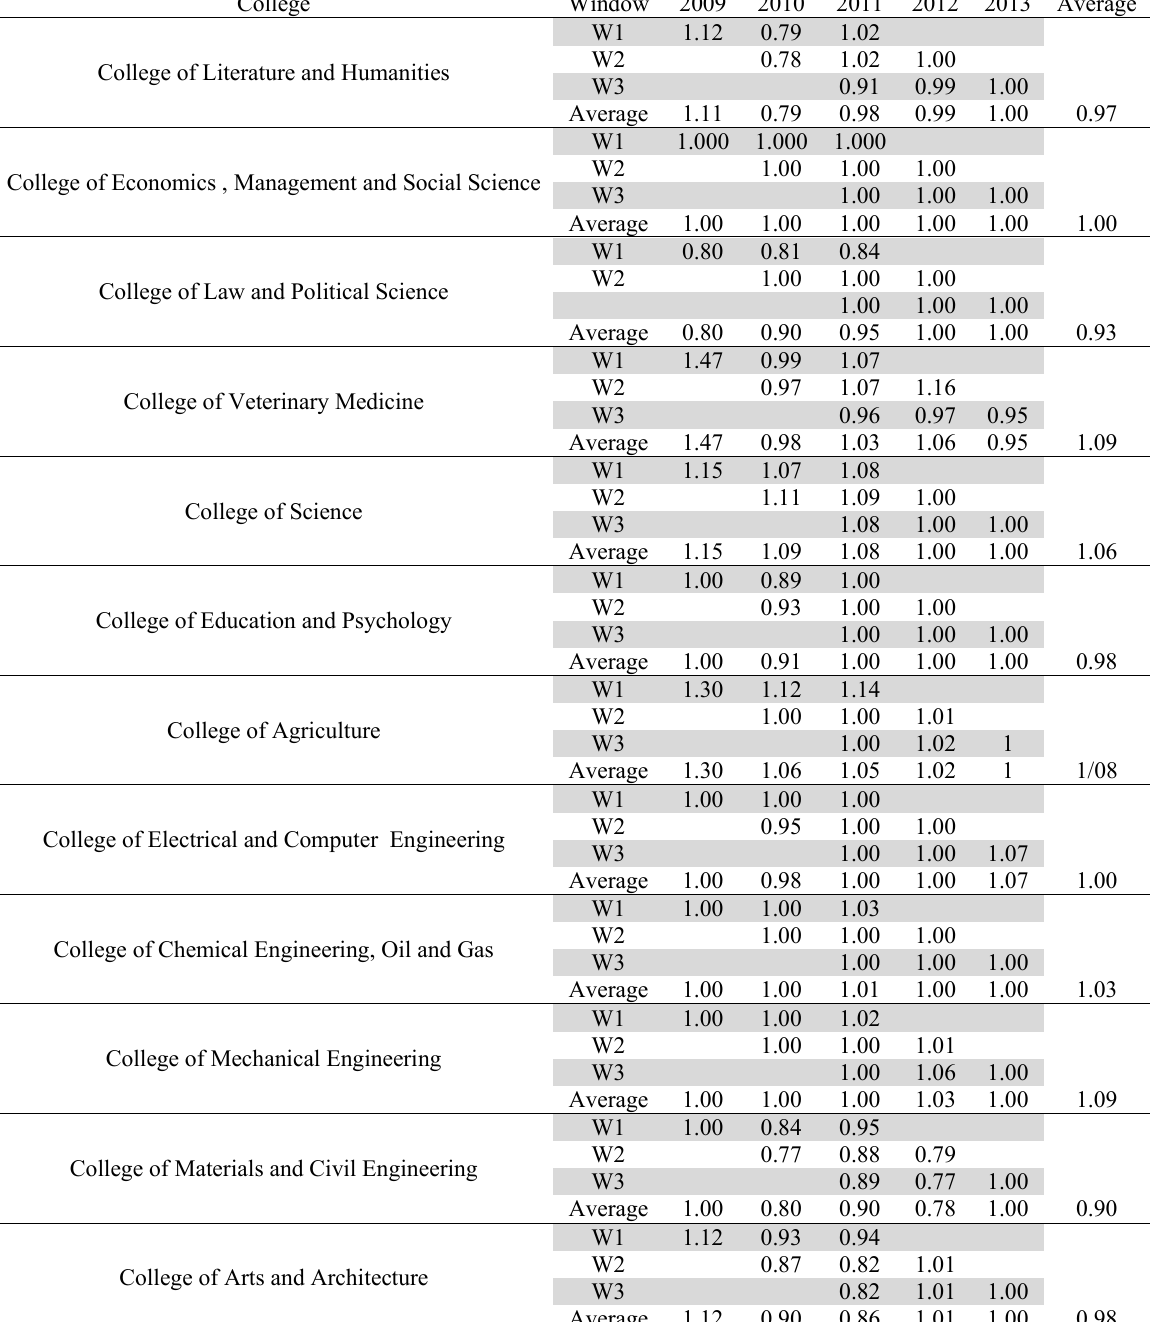
Window data analysis results with double